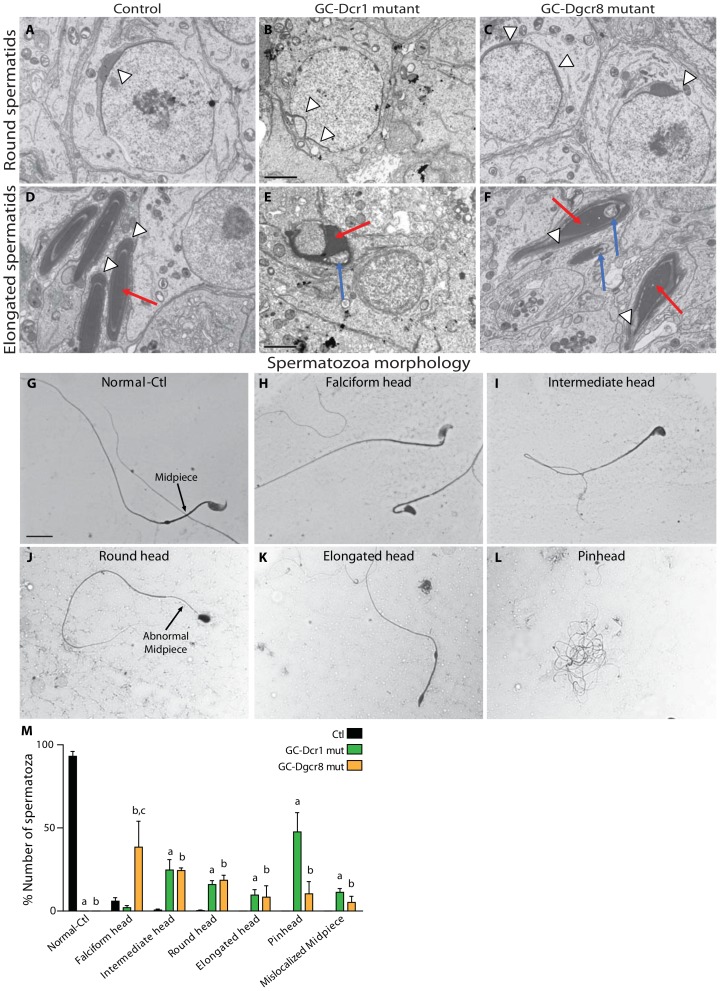
Impaired spermiogenesis leads to altered morphology of spermatozoa in both GC-Dcr1 and GC-Dgcr8 mutants at P60.Representative transmission electron micrographs from P60 control (A, D), GC-Dcr1 mutants (B,E) and GC-Dgcr8 mutants (C,F). In round spermatids (A–C), the acrosome is fragmented or asymmetric in both mutants (arrowheads). In elongated spermatids (D–F), nuclear shape (red arrows), chromatin condensation and the acrosome (arrowheads) are abnormal in both GC-Dcr1 and GC-Dgcr8 mutants. Note the presence of vacuoles within nuclei (blue arrows) in both mutants. Scale bar: 2 µm. H&E staining of epididymal sperm spreads of control (G) and mutant (H–L) adult mice. In contrast to control mice, spermatozoa of both mutant mice exhibited multiple defects of morphology, such as falciform head (H), intermediate head (I), round head (J), elongated head (K), pinhead (L) and abnormal midpiece (J). Scale bars: 10 µm. The histogram shows the percentage of spermatozoa in each category (M). Results are mean ± SEM (minimum n = 3/genotype), a = p<0.005 GC-Dcr1 mut vs. control, b = p<0.005 GC-Dgcr8 mut vs. control and c = p<0.005 GC-Dcr1 mut vs. GC-Dgcr8 mut.